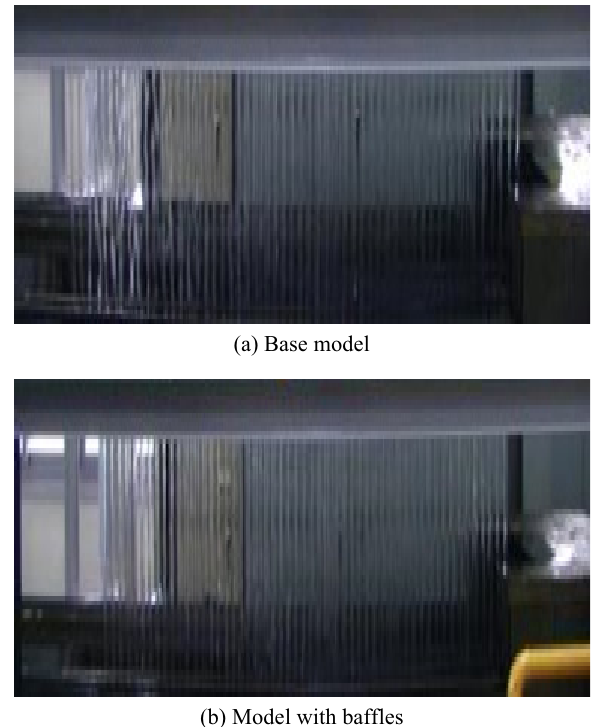
Figure 7. Photographs of the water distribution of the manifold: (a) Base model, (b) Model with the